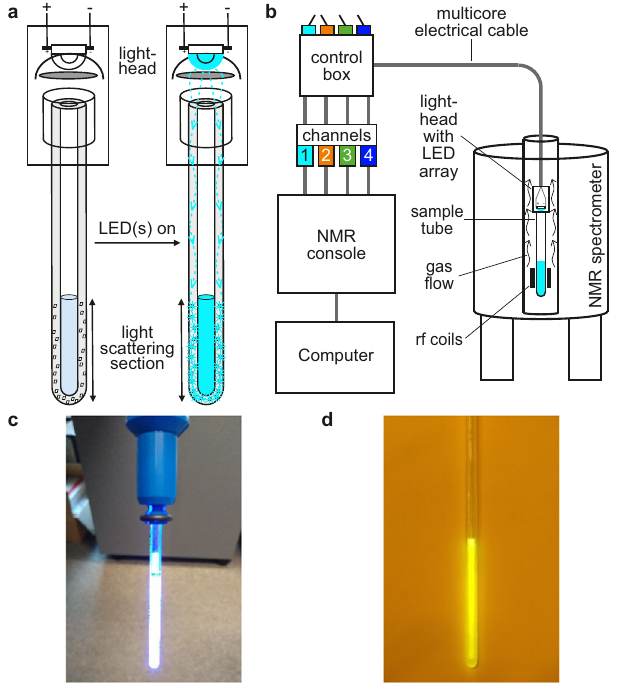
Fig. 1 Principles of the NMRtorch. a Principle of the NMRtorch approach, with the NMR sample tube acting as a light guide. b Schematic of the NMRtorch setup. Not to scale. c Appearance under ambient light on an example NMRtorch tube fi lled with a typical sample and illuminated with 3 W 460 nm blue LED. Scattered light appears as white due to oversaturation of the photoimaging sensor. d Image of saturated solution of fl uorescein sample illuminated by blue light, taken under ambient light through orange fi lter. The vibrant yellow fl uorescence is visibly uniform across the